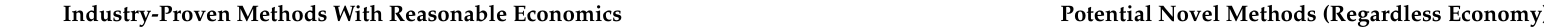
Table 9. Potential novel methods of the water treatment in power generation sector, regardless their economic and technical characteristics, just only according to their theoretical presumptions (list of abbreviations bellow, page